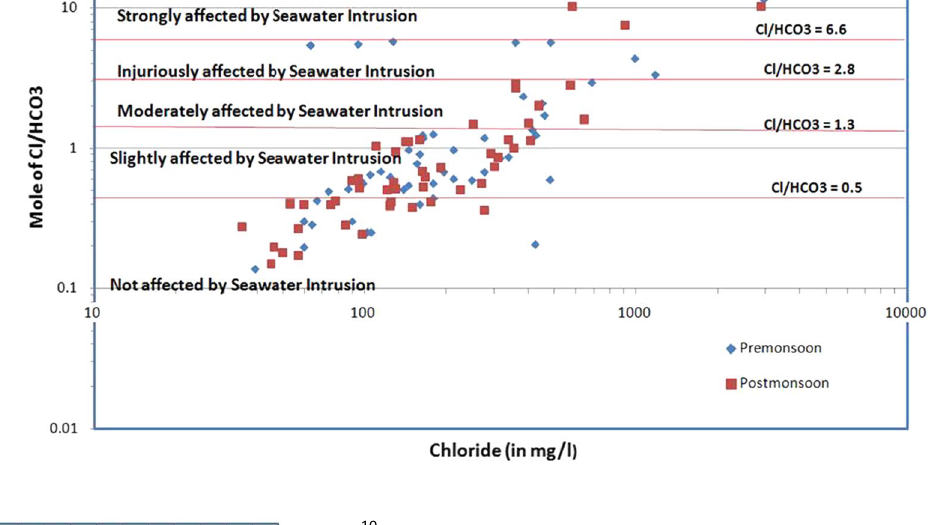
Fig. 6 Relationship of mole ratio of Cl/HCO 3 to Cl in groundwater of pre-monsoon and post-monsoon